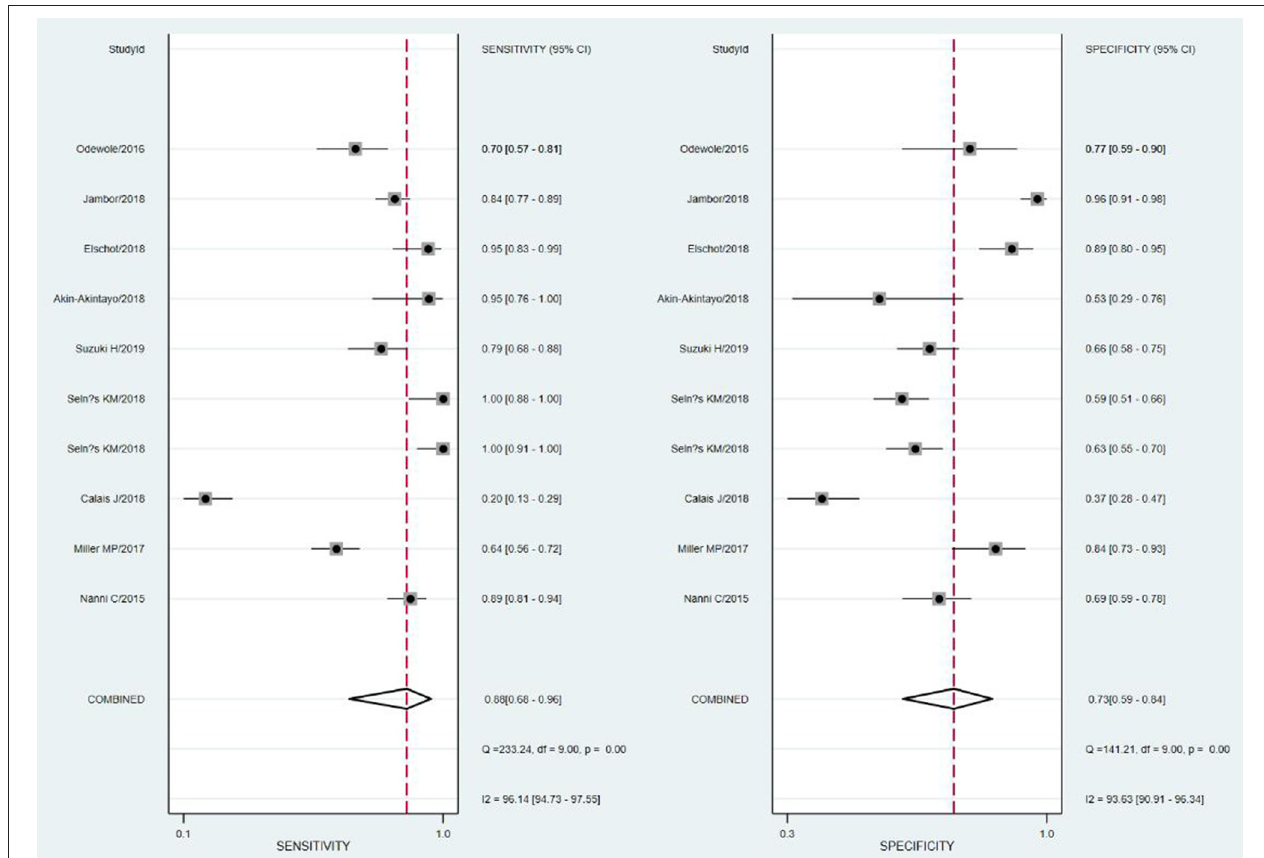
FIGURE 4 | Forest map of 18F-fluciclovine PET/CT for diagnosis of prostate cancer. patient selection. The research quality evaluation is shown in Figure 1